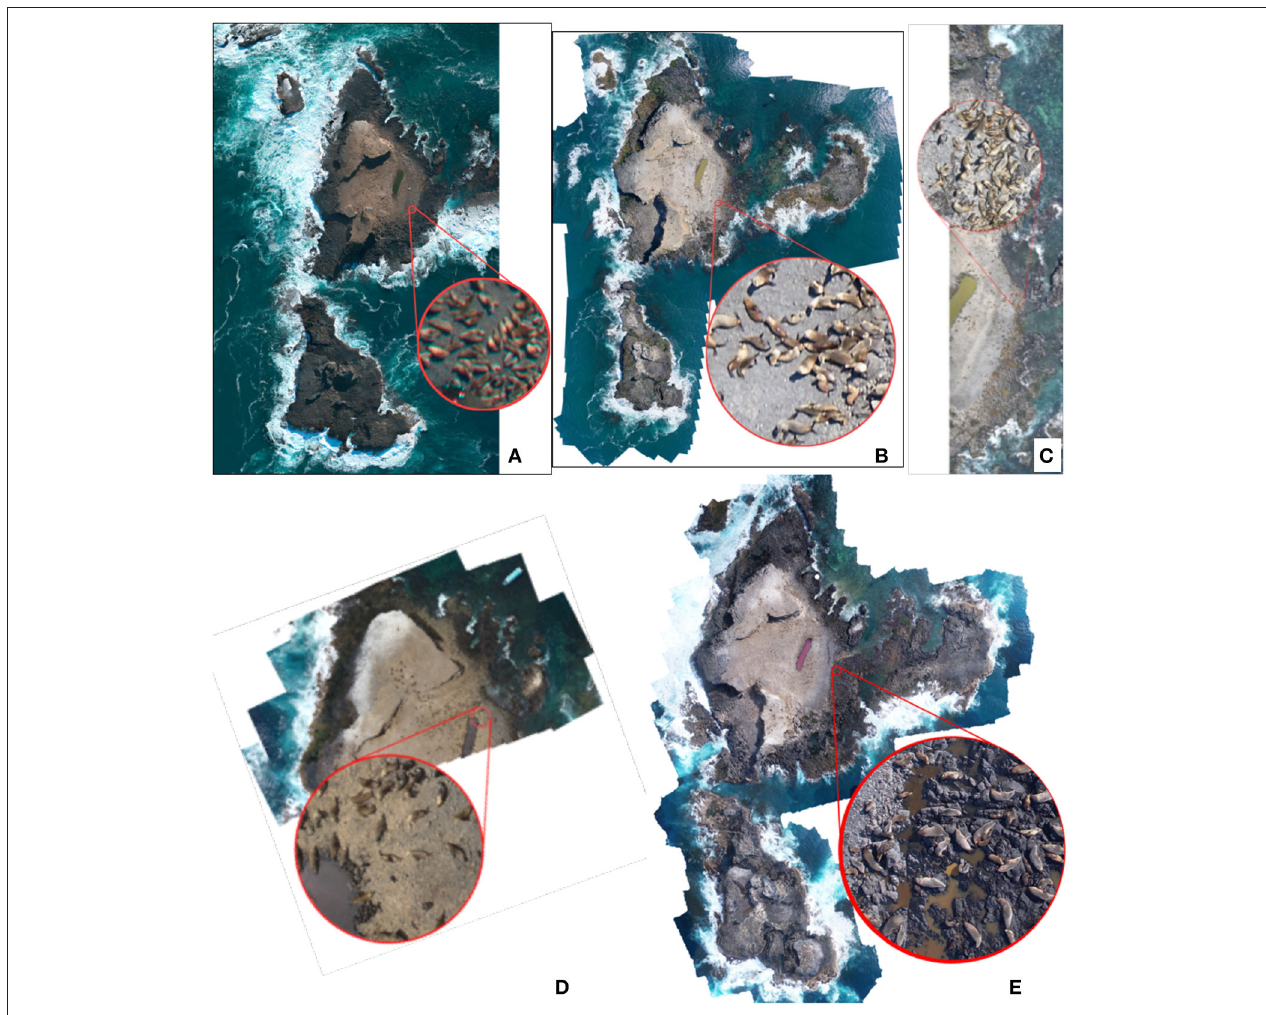
FIGURE 2 | Stitched images from trials (Left to right: upper A–C and lower; D,E ), with inset zooms to show resolution and clarity achieved. (A) Gryphon Dynamics RPA survey 1, using a 16mm lens and 42 MP sensor at 80m ASL. Resolution is not high enough to be useful for research purposes. (B) Gryphon Dynamics RPA Survey 2 using a 16mm lens and 42 MP sensor at 60m ASL. Resolution is higher with this configuration than from the first survey (A) due to lower flight altitude. (C) Gryphon Dynamics RPA survey 3 (part survey only), flown at 60m ASL using a 28mm lens and 42 MP sensor. Detail of the seals is of a higher resolution than earlier surveys (A,B) due to narrower field of view. (D) Phantom 4 RPA survey 4, flown at 60m ASL, using 20mm equiv. lens and 12.4 MP sensor. (E) Phantom 4 Pro RPA, flown at 40m ASL. Twenty-four millimeters equivalent lens, 20 MP sensor. Resolution and image clarity here are at a level where identifying individual animals, even when clustered and on dark rocks, is possible. Image is of similar resolution to the larger RPA at 60m with 28mm lens (C)